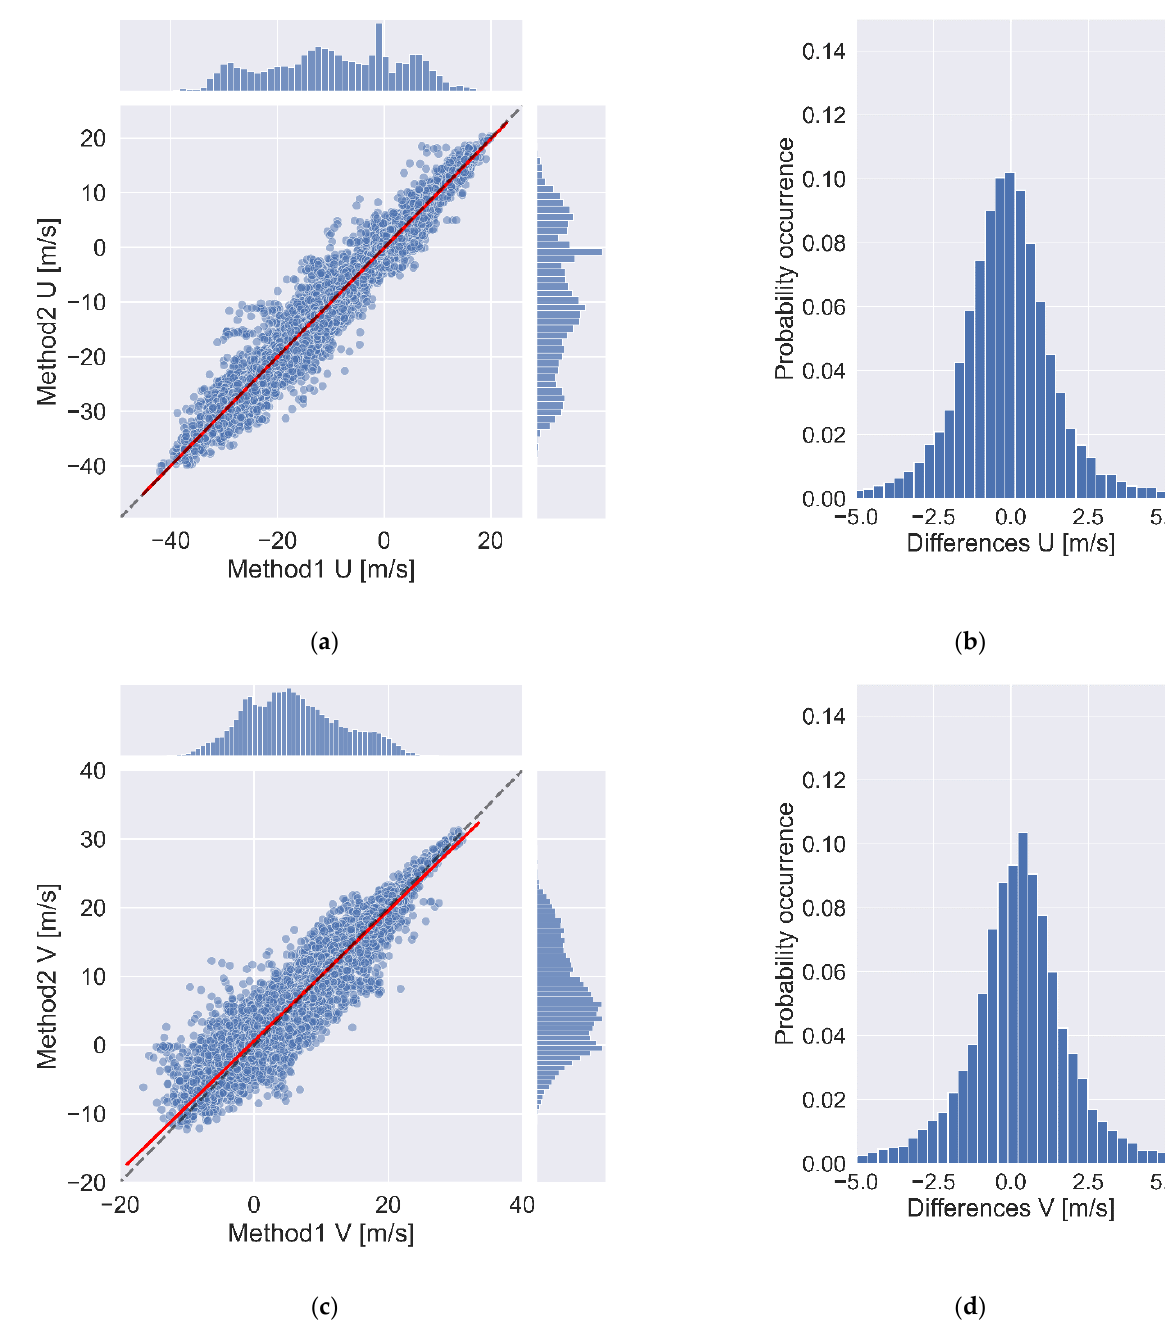
Figure 8. Scatterplots and distributions of differences between ALWPP (Method1) and UBWPP (Method2) for zonal component U, panels ( a , b ), and meridional component V, panels ( c , d ). Scatter plots show correlation (red) and perfect correlation in diagonal (dashed) lines.